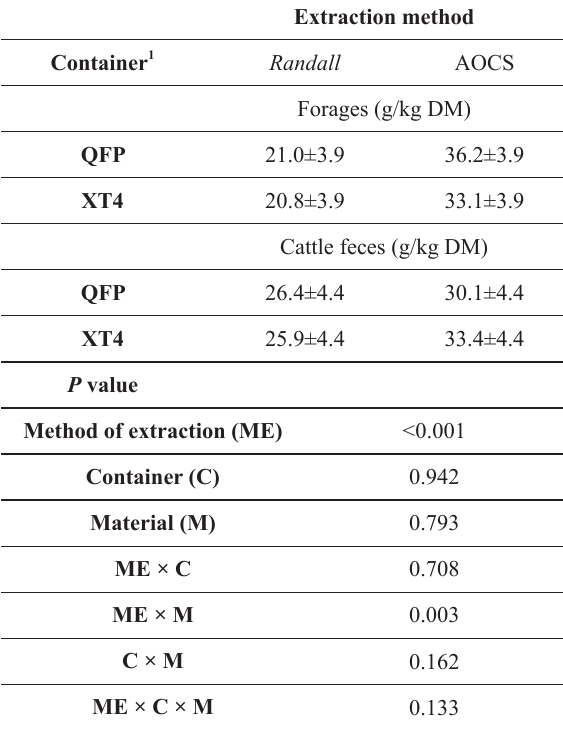
Ether extract contents in forages and cattle feces according to extraction method and container type.